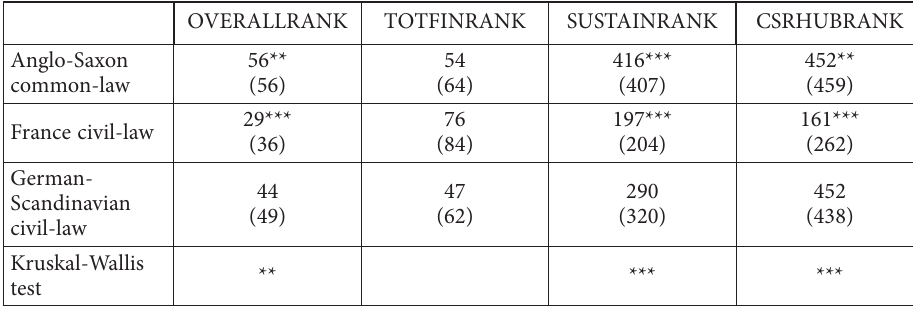
Table 8. The importance of the CEO’s country of origin Panel A: Median (mean) positions in rankings by region 3 OVERALLRANK TOTFINRANK SUSTAINRANK CSRHUBRANK Anglo-Saxon common-law